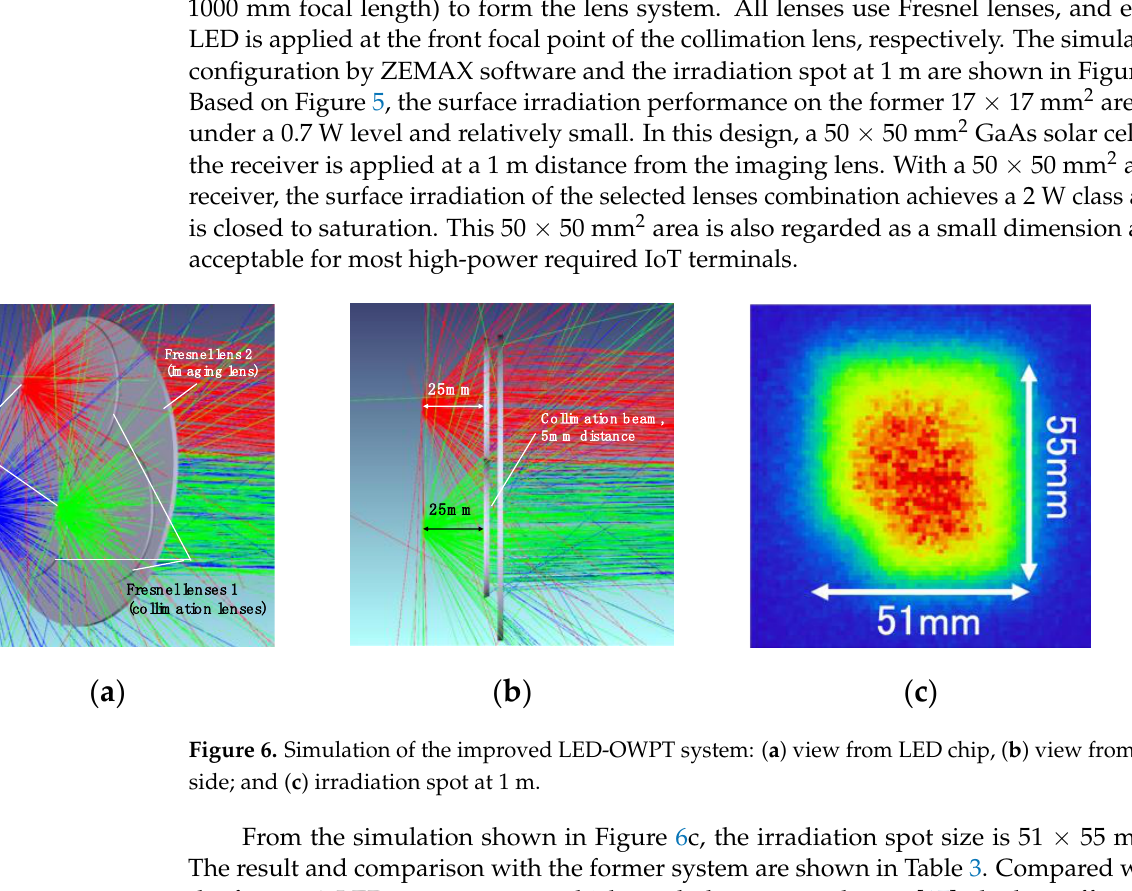
Table 3. Simulated efficiency at 1 m and measured parameters of a 3-LED-OWPT